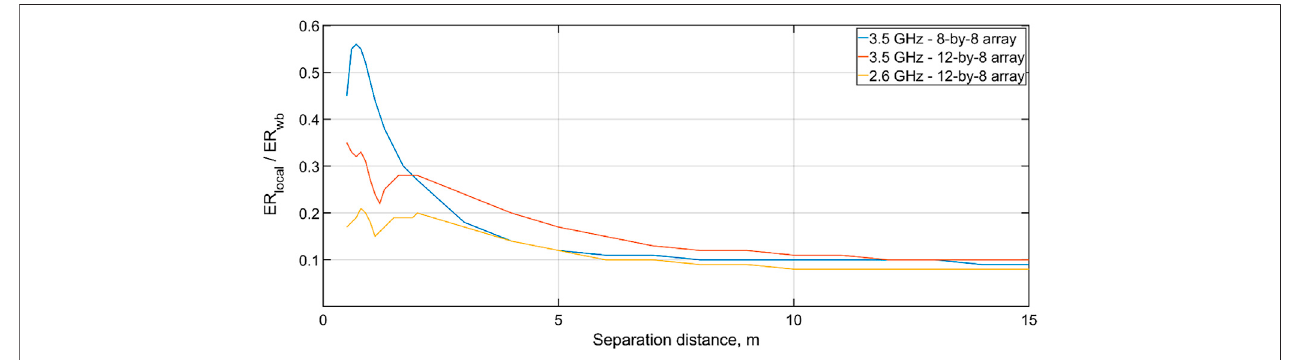
FIGURE11| Ratiobetweenpeak-spatiallocalizedSAR( SAR local )andwhole-bodySAR( SAR wb )normalizedtotheirrespectivelimits,asafunctionoftheseparation distance for mMIMO BS antennas at 2.6 and 3.5